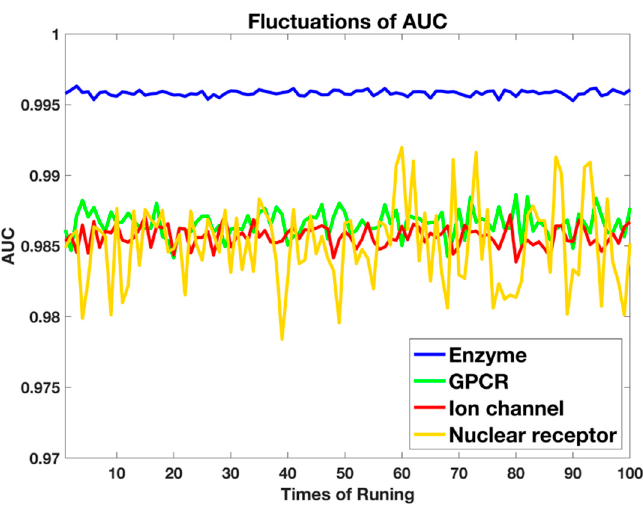
Figure 2. The fluctuations of AUC values in four subdatasets after executing 100 times.